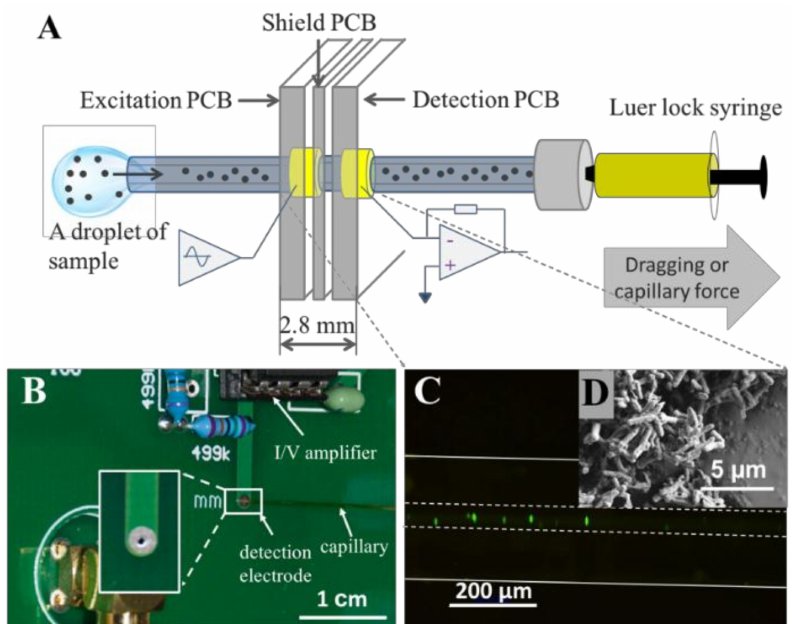
Figure 1. ( A ) Schematic illustration of capacitively coupled contactless conductivity detection (C 4 D) device on detecting bacterial concentration. ( B ) The printed-circuit-board (PCB) based electrodes. ( C ) Fluorescence-labeled Escherichia coli in capillary. ( D ) Scanning electron microscope (SEM) image of E. coli , the length of which on average is about 2 µ